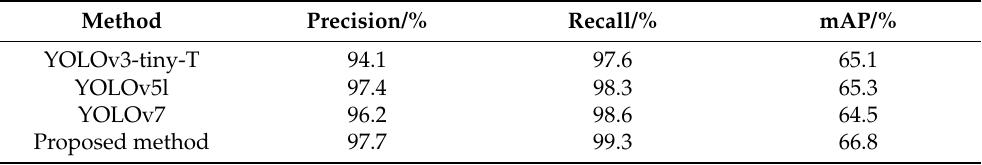
Table 3. Experimental results of different methods with the TinyHGR dataset.